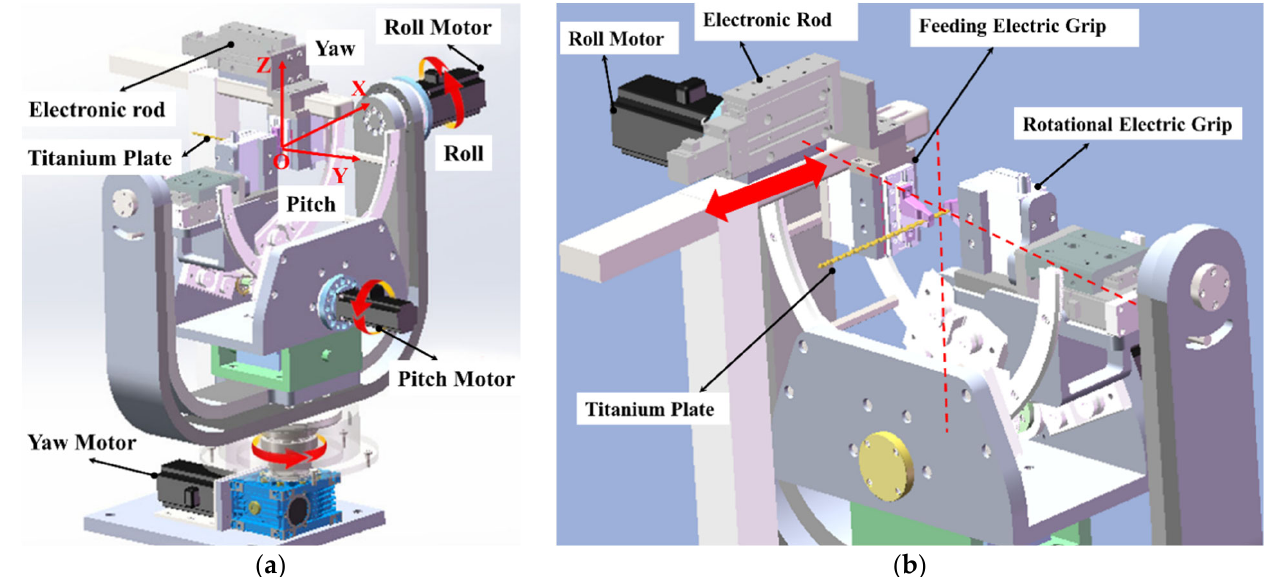
Figure 1. ( a ) 3D model of Bending and Forming Robot: overall view. ( b ) 3D model of Bending and Forming Robot: upper half part.